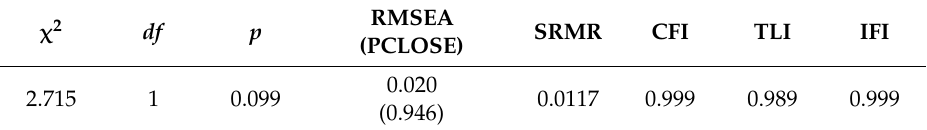
Table 3. Quality criteria of the model adaptation.